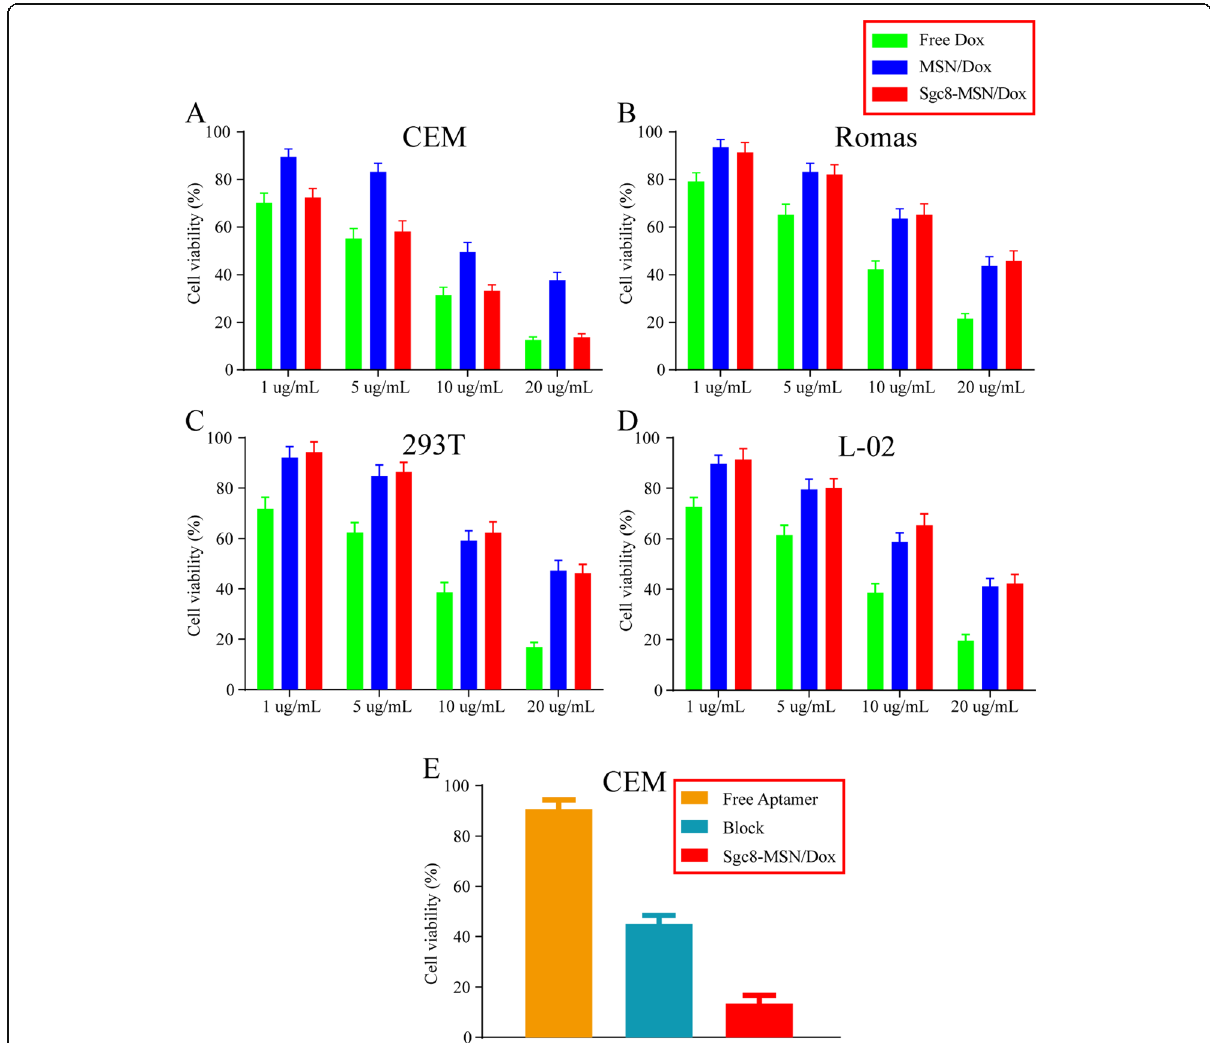
Fig. 7 Ability of free DOX, MSN/Dox, and Sgc8-MSN/Dox to kill a CEM cells, b Ramos cells, c 293T cells, and d L-02 cells. e CEM cells killing ability of free aptamer, block (CEM cells first incubate sufficient Sgc8 for 2 h, then incubated with sgc8-MSN/Dox), and